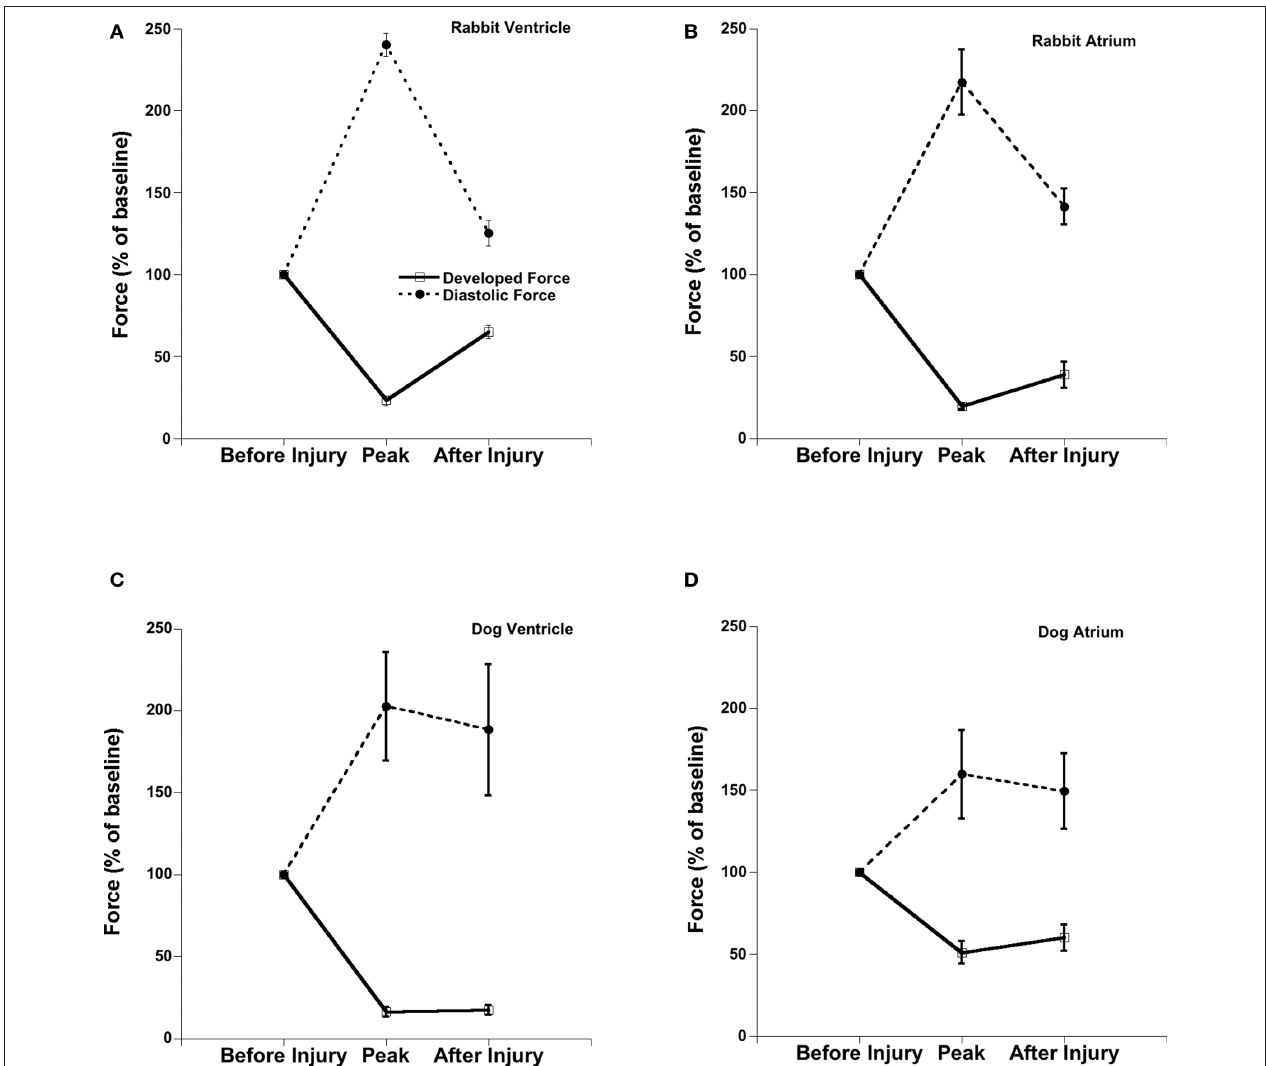
FiguRe 3 | Comparison of percentage effect of OH-radicals on the contractile parameters of the ventricular and atrial trabeculae in rabbit and dog. Stimulation frequency 2 Hz in rabbit and 1 Hz in dog and temperature was 37 ° C throughout the experiment. (A) Rabbit Ventricle, (B) Rabbit Atrium, (C) Dog Ventricle, (D) Dog